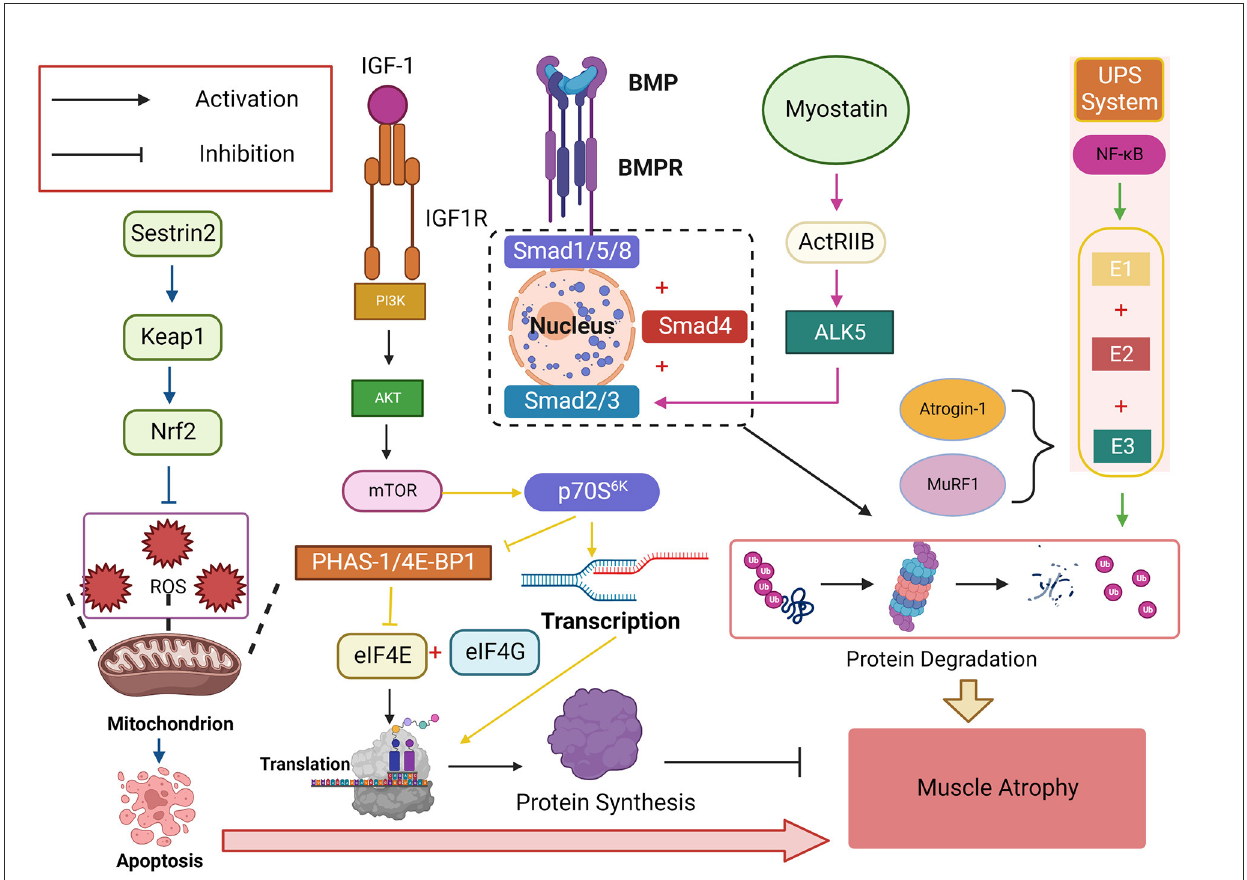
FIGURE4 The insulin-like growth factor-1 (IGF-1)/phosphatidylinositol trikinase (PI3K)/threonine kinase (Akt)/mammalian target of rapamycin (mTOR) signaling pathway is a critical signaling pathway that promotes protein synthesis and plays a vital role in regulating skeletal muscle mass. Its downstream target p70S6K can promote protein transcription while inhibiting eIF4E, a negative regulator of PHAS-1/4E-BP1, which binds eIF4E to eIF4G and initiates translation. NF- κ B activates ubiquitin-proteasome System (UPS) and degrades proteins by binding E1, E2, and E3, with Atrogin-1 and muscle-specific RING finger protein 1 (MuRF1) being the two most common E3s Ligase, bone morphogenetic protein (BMP) affects the signaling pathway of Smad1, Smad5, and Smad8 (Smad1/5/8) protein phosphorylation and finally converges to Smad4. Myostatin-ActRIIB-ALK5-Smad2/3 is another